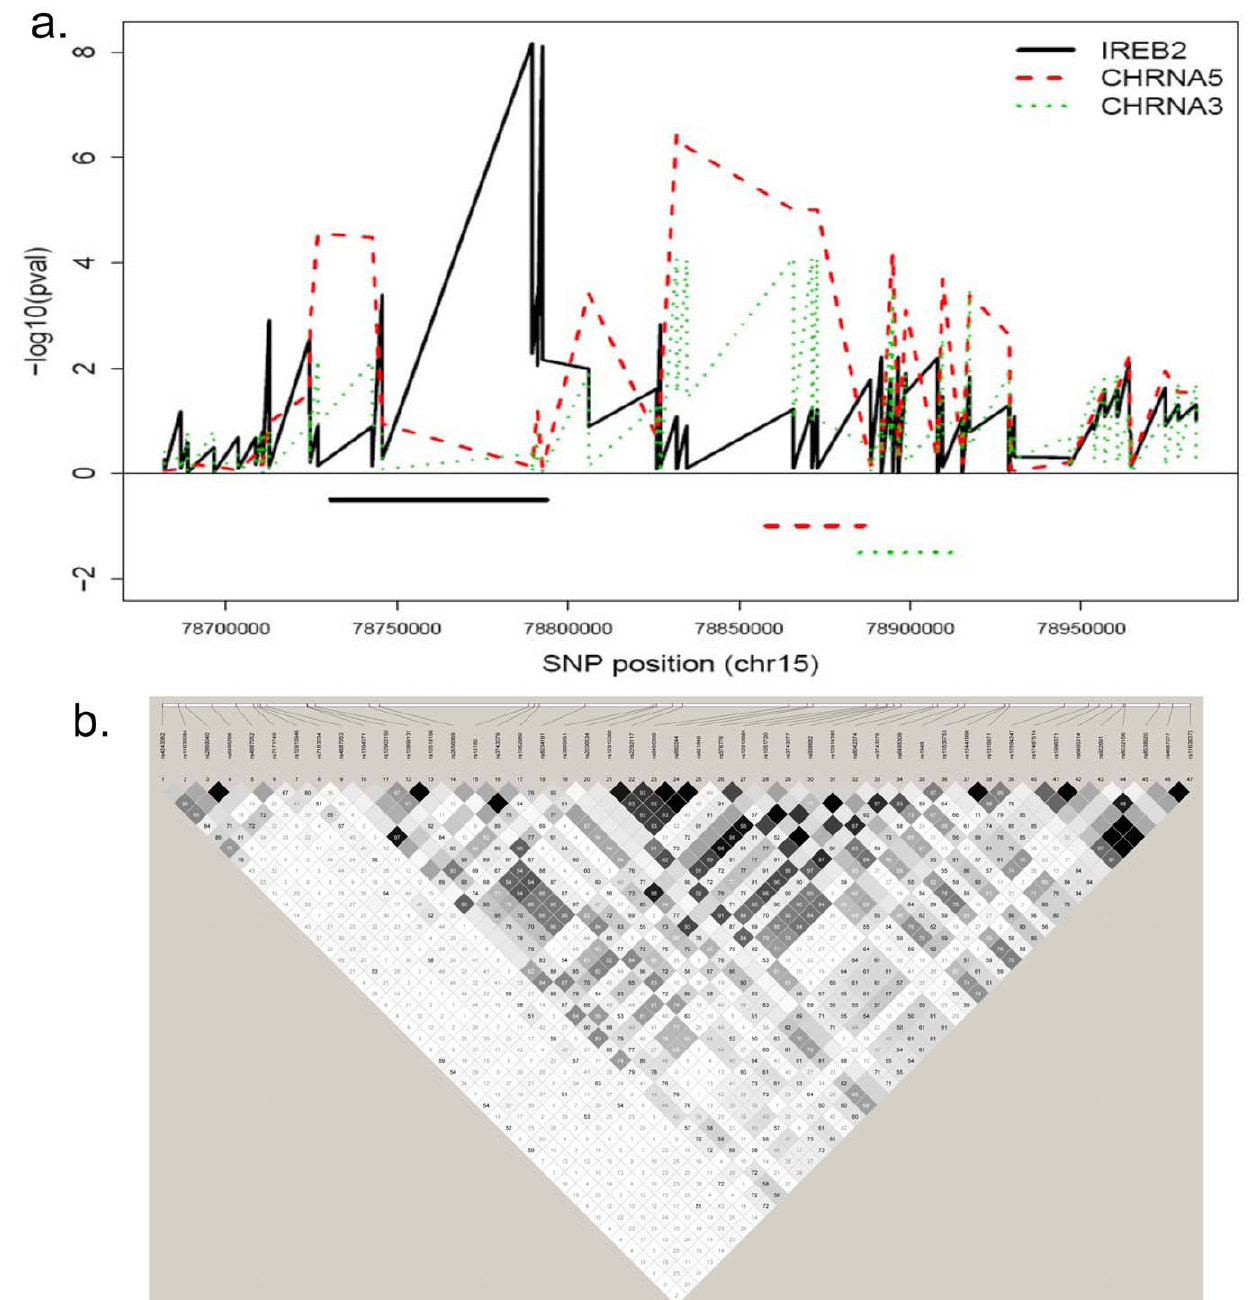
Figure 3. Detailed analysis of the chromosome 15q25 chronic obstructive pulmonary disease (COPD) locus. a) Association between single nucleotide polymorphisms (SNPs) in the chromosome 15q25 COPD locus and expression levels of IREB2 (1555476_at), CHRNA5 (206533_at) and CHRNA3 (211587_x_at) in sputum samples from 131 Evaluation of COPD Longitudinally to Identify Predictive Surrogate End-points (ECLIPSE) subjects. SNP rs numbers are listed in Table 4. b) Linkage disequilibrium r 2 values between SNPs in the chromosome 15q25 COPD locus (listed in Table 4) in 131 ECLIPSE subjects.